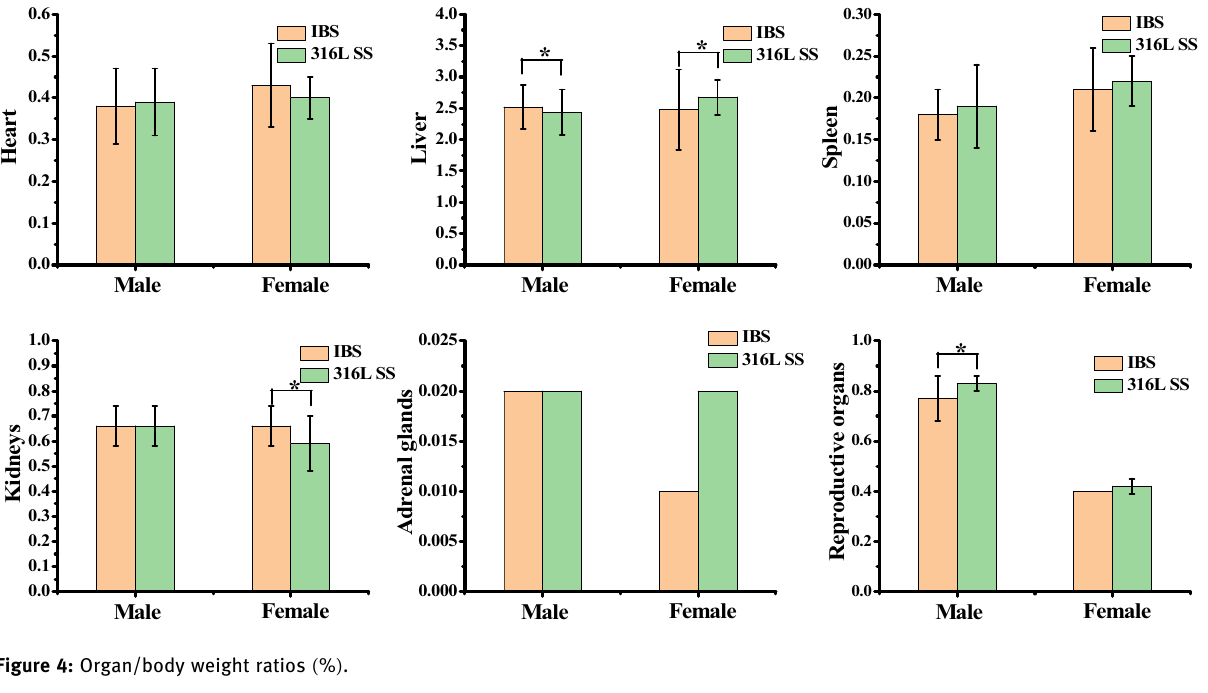
Figure 4: Organ/body weight ratios ( % ) .